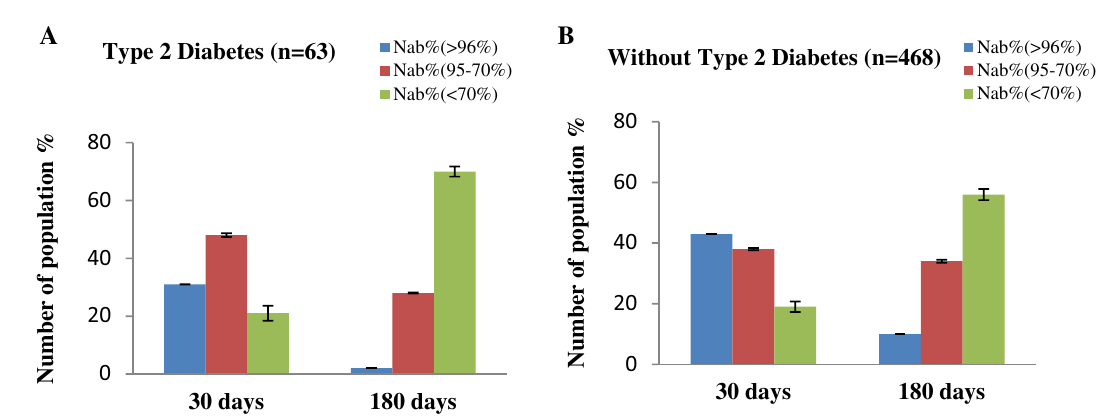
Figure 7. Percentage (%) of people with immune responses in ( A ) Type 2 Diabetes ( B ) Without Type 2 Diabetes after 30 days and 180 days of completing 2nd immunization.